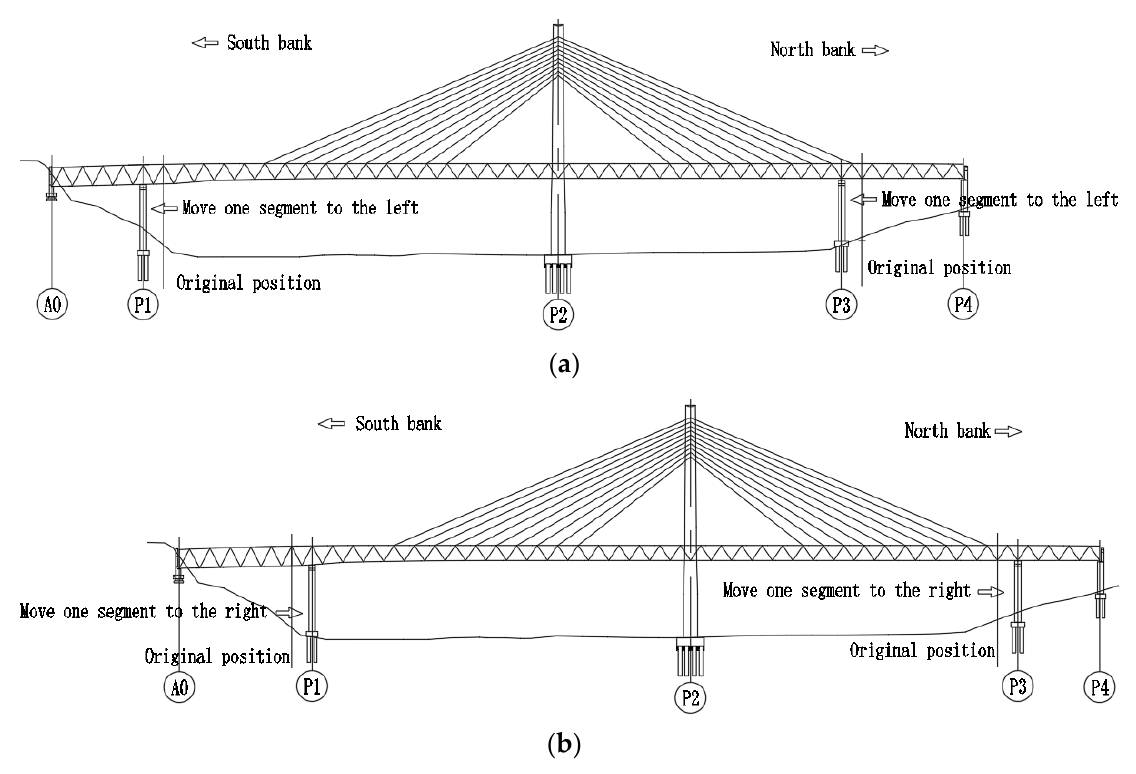
Figure 9. The movement of auxiliary piers: ( a ) the auxiliary piers move one segment to the left; ( b ) the auxiliary piers move one segment to the right.